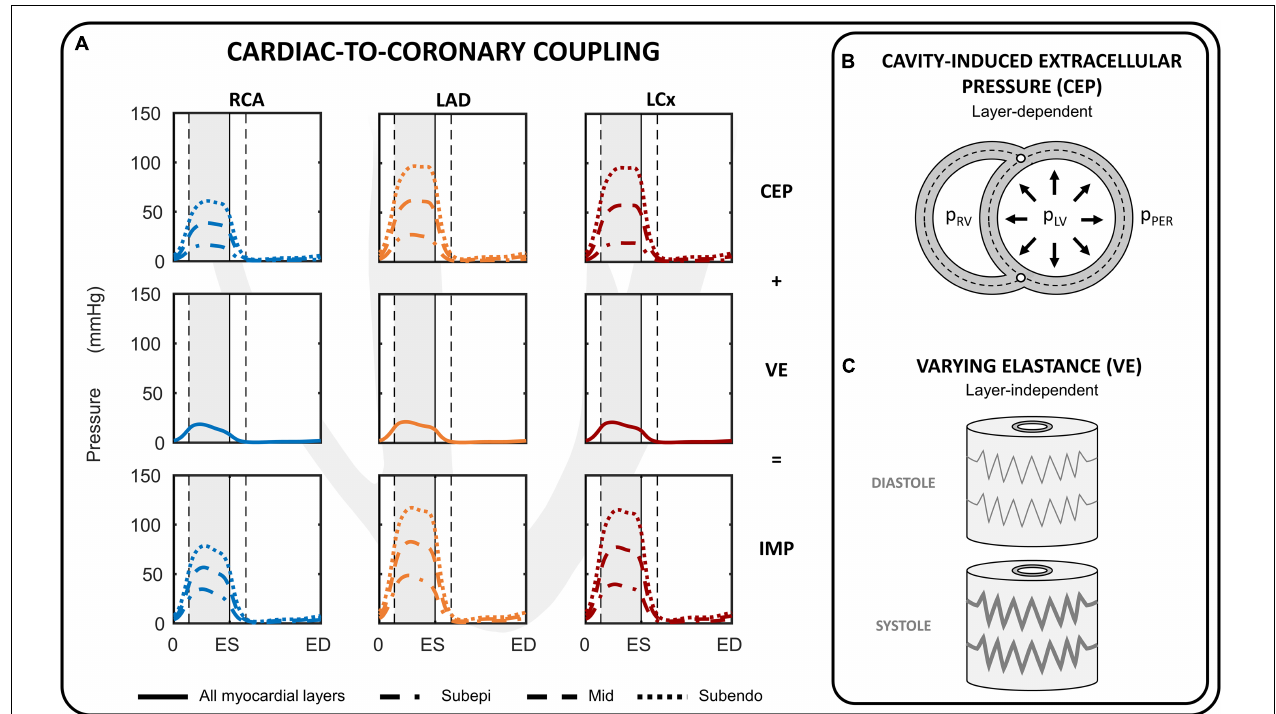
FIGURE 2 | Cardiac-to-coronary coupling. (A) Overview of the intramyocardial pressure (IMP) during one cardiac cycle for the right coronary artery (RCA), left anterior descending (LAD) and left circumflex (LCx). The IMP is assumed to consist of two components: cavity-induced extracellular pressure (CEP) and myocardial stiffness (labeled as varying elastance; VE). (B) CEP arises from transmission of cavity pressure in the myocardial wall and varies linearly from cavity pressure (p LV , p RV ) at the endocardial border to pericardial pressure (p PER ) at epicardial border for the left and right ventricular free walls. (C) VE was directly related to fiber stress. ED, end-diastole; ES, end-systole.